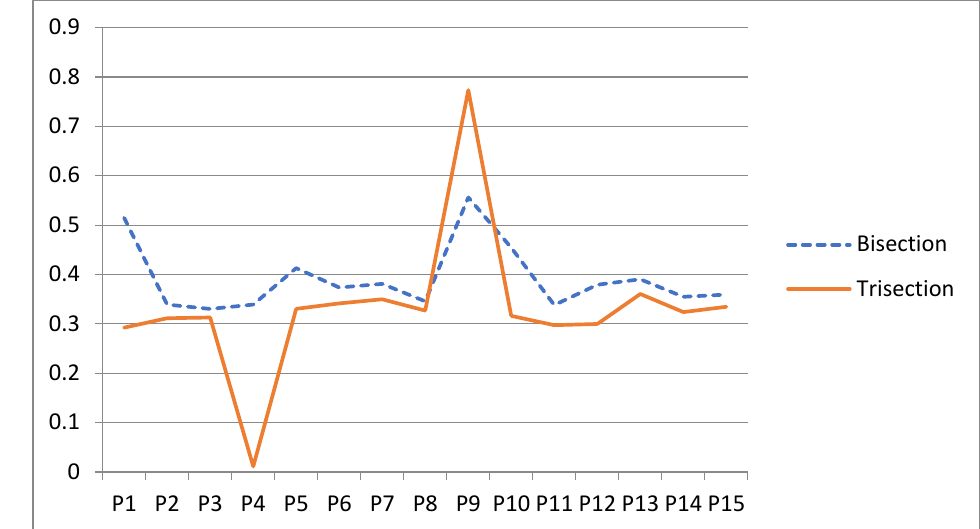
Figure 2. A comparison among 7 methods on 15 problems according to the number of iteration.